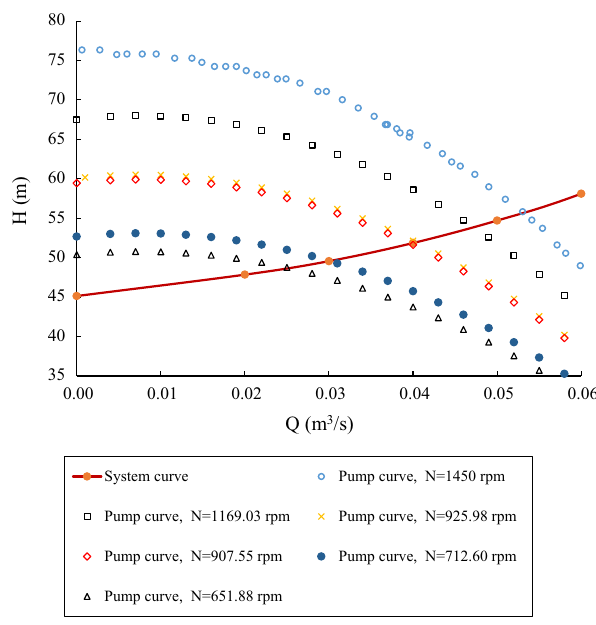
Fig. 6 Operating points of the system at different pump speeds